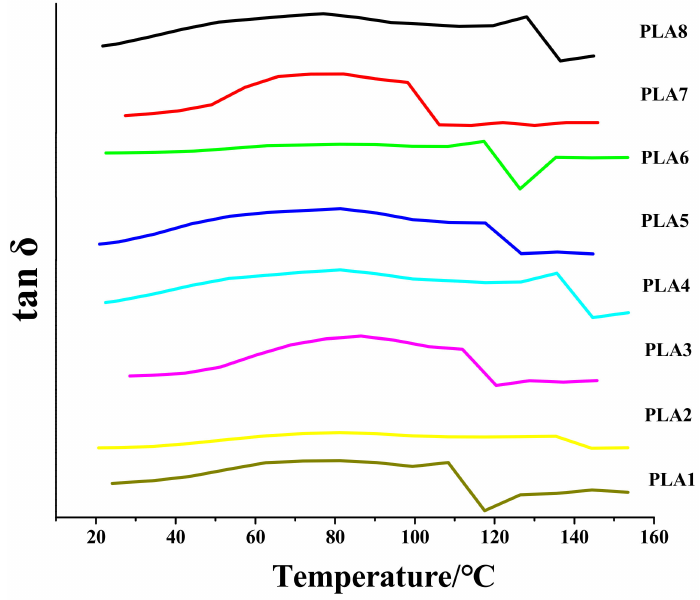
Figure 1. Analysis of DMA Loss Factor of BSP / PLA Composite Films with Di ff erent Proportions. Temperature / Loss Factor